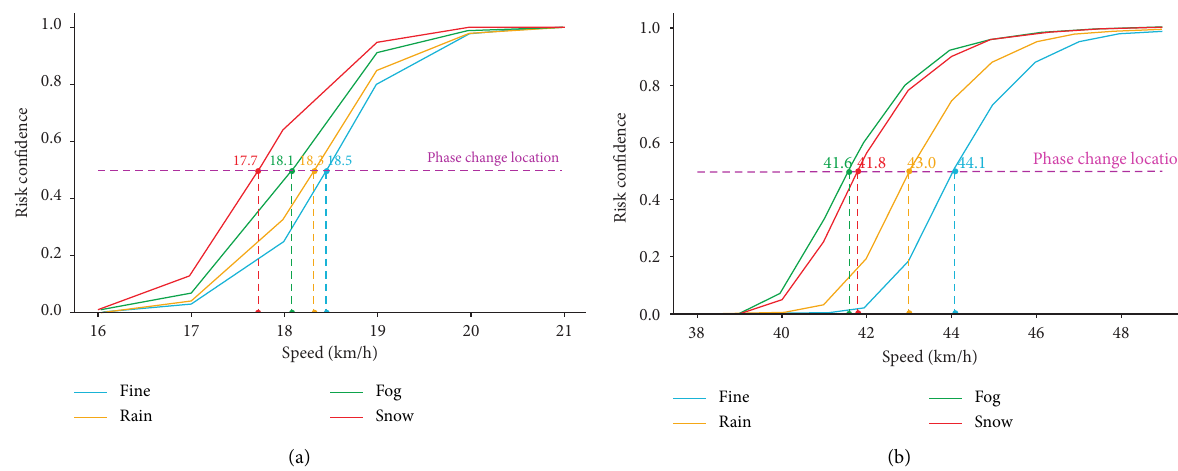
Figure 22: (a) Comparison of fatigue driving risk. (b) Comparison of driving risk probability under different weather conditions.